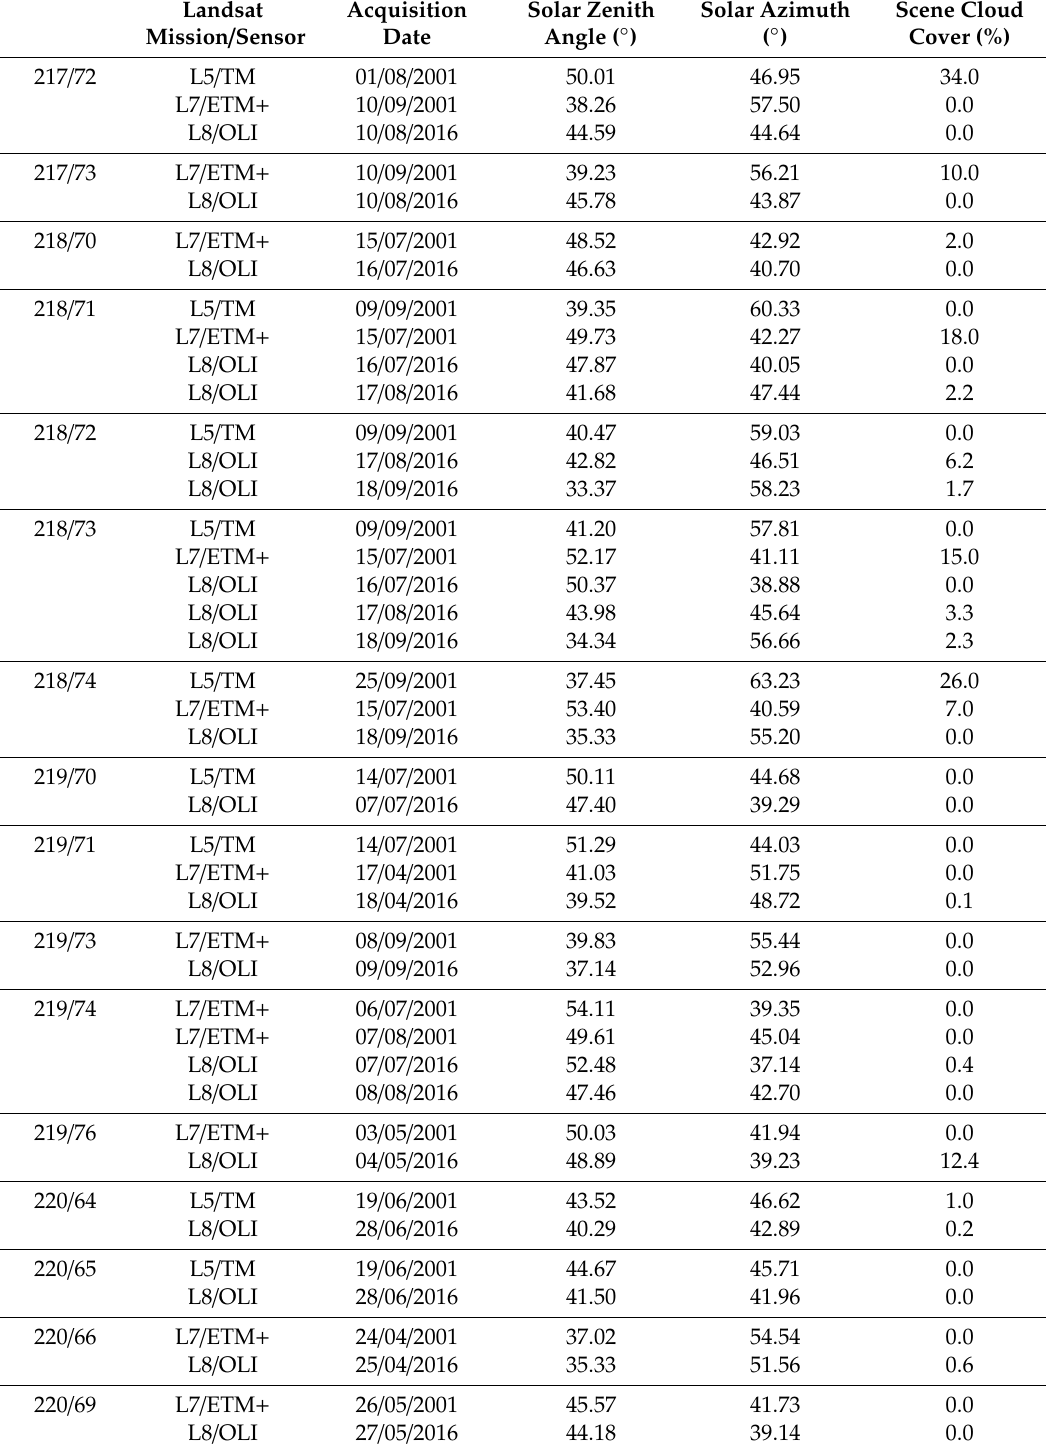
Table A3. Acquisition details of the selected Landsat scenes (the areas a ff ected by cloudiness are located outside the limits of the studied